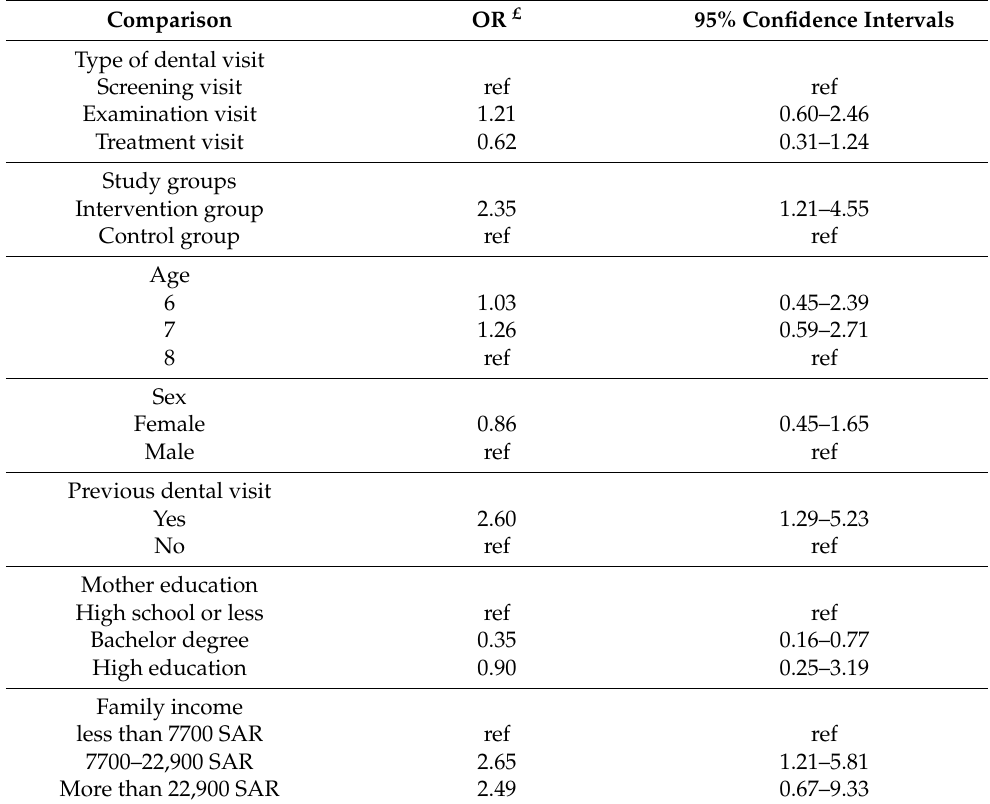
Table 7. Multivariate mixed-effects logistic regression model analysis for factors affecting patients’ anxiety with